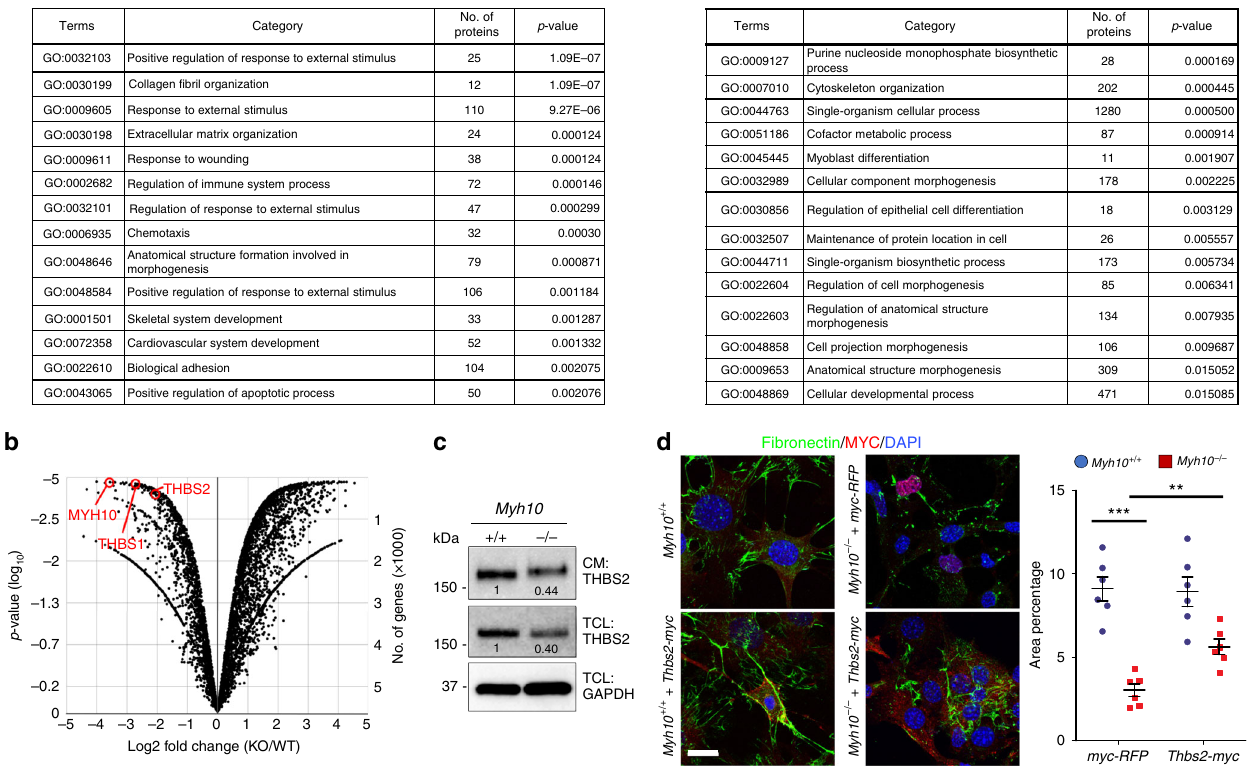
Fig. 4 MYH10 modulates MMP activity by regulating THBS. a GO classi fi cation (all components with P -value < 0.05) of differentially expressed proteins between Myh10 + / + and Myh10 -/- fi broblasts. b Volcano plot of the log 2 ratio of differentially expressed proteins between Myh10 + / + ( n = 3) and Myh10 -/- ( n = 3) fi broblasts. c Representative western blot (from three individual sets of cultured cells) for THBS2 from Myh10 + / + and Myh10 -/- fi broblasts. Values represent the densitometric ratio of Myh10 -/- to Myh10 + / + after normalization to GAPDH. CM, conditioned medium; TCL total cell lysate. d Immunostaining and quanti fi cation (from four individual sets of cultured cells) for fi bronectin and Myc epitope of Myh10 + / + and Myh10 -/- fi broblasts transfected with myc-RFP or Thbs2-myc . Error bars are means ± s.e.m. ** P < 0.01, *** P < 0.001, two-tailed Student ’ s t -test. Scale bar: 20 μ m ( d